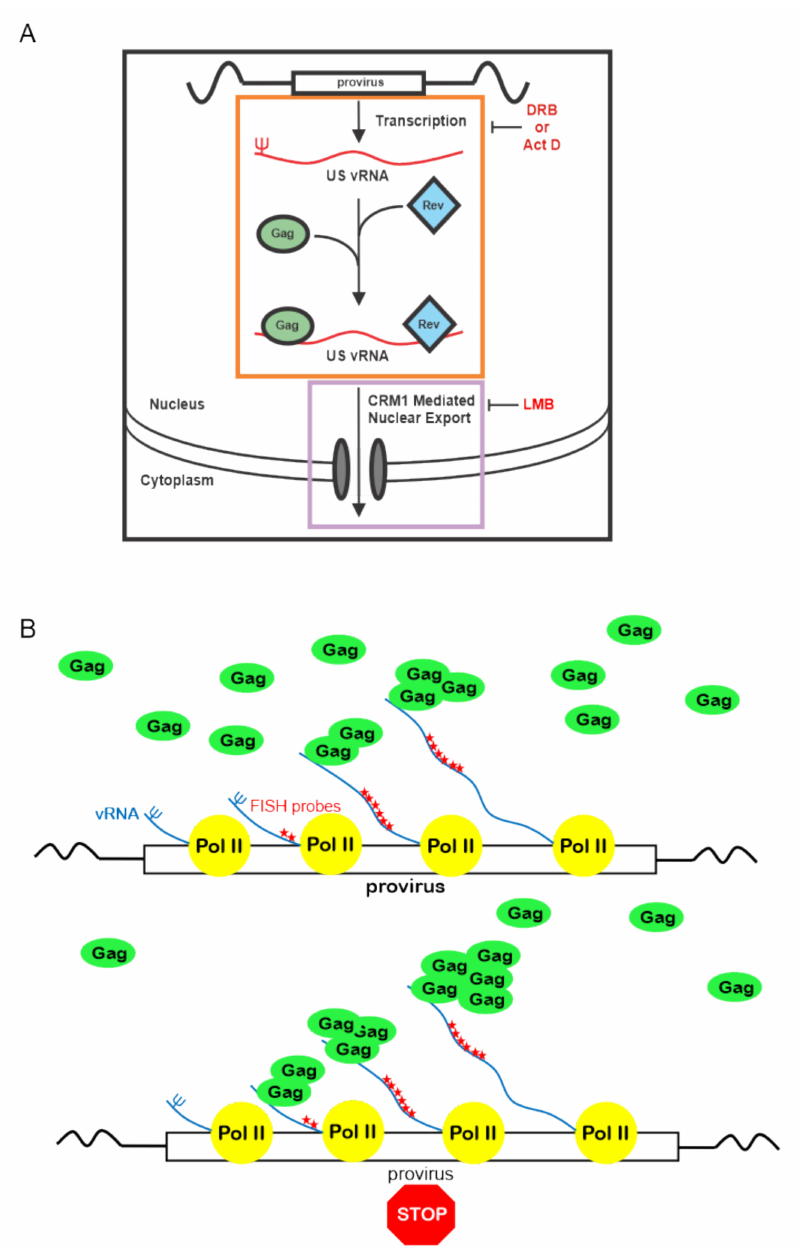
Figure 9. Proposed model of HIV-1 Gag association with USvRNA during transcription. ( A ) Our results demonstrate that treatment of HeLa HIV.Gag-GFP rtTA cells with Act D or DRB caused Gag to accumulate on USvRNAs that may be at or near transcription sites (orange box). Because Rev also binds USvRNA co-transcriptionally, there is a possibility that both Gag and Rev associate with USvRNA at transcription sites. Nuclear export of USvRNA was inhibited by LMB (purple box), along with small increase in HIV-1 Gag-GFP nuclear foci, yet there was no change in the degree of Gag-USvRNA co-localization. This finding suggests that there is a narrow “window of opportunity” for Gag-USvRNA to form vRNP complexes, starting at transcription but ending prior to formation of the export complex. ( B ) The model proposes that Gag binds to the 5 (cid:48) UTR psi sequence as it emerges during transcription. With transcription inhibition, Gag accumulates on stalled transcription complexes leading to an increase in Gag-USvRNA co-localization, potentially through additional Gag-Gag or Gag-RNA